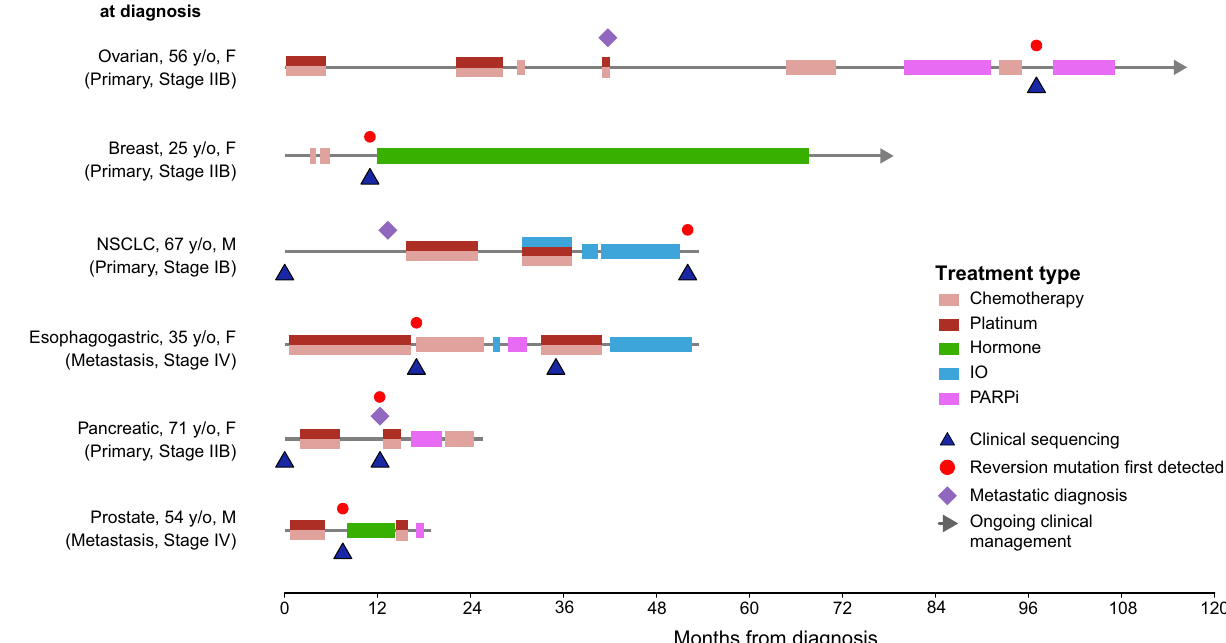
Fig. 3 | Timeline of treatment for patients whose tumors developed reversion mutations. M male, F female, PARPi poly(adenosine diphosphate ribose) polymerase (PARP) inhibitor, IO